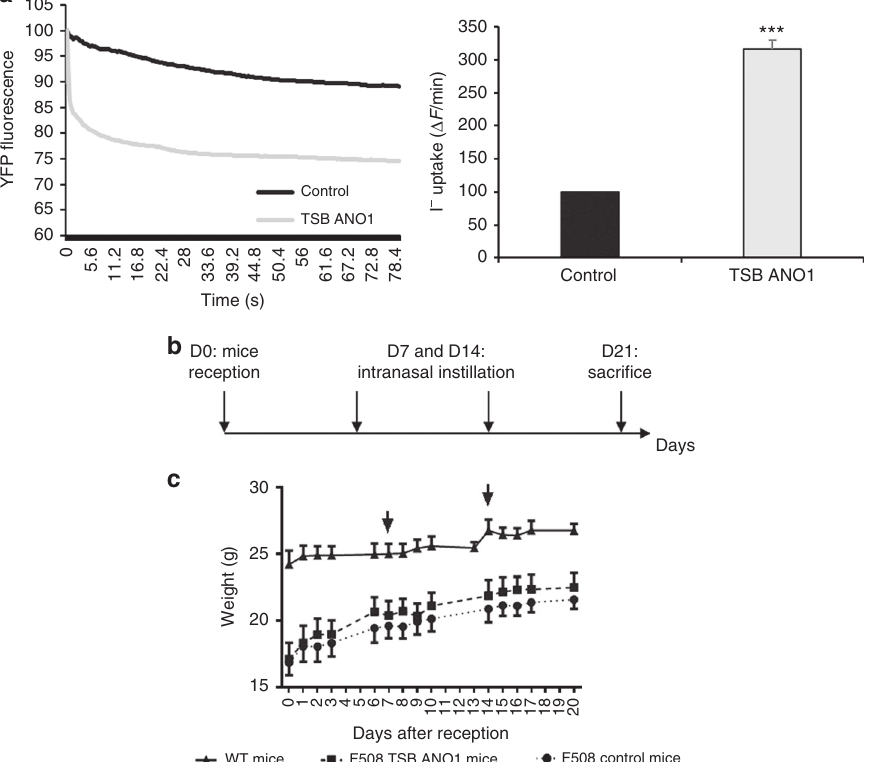
Fig. 6 miR-9-speci fi c TSB is well tolerated in CF mice. For all the experiments, we used 8-week-old male 129-C ftr t m1Eur CF model mice homozygous for the F508del mutation in the 129/FVB outbred background (F508del-CFTR) and their wild-type littermates obtained from CDTA-CNRS (Orléans, France). a Representative and original traces of ANO1 channel activity ( left ) and quanti fi cation ( right ) of MLE15 cells transfected with TSB control (control) or ANO1 TSB. Histograms represent average values ± SDs ( n = 5) and were compared using Student ’ s t -test. b Outline of the CF mouse experiment. TSB control or ANO1 TSB was instilled intranasally at days 7 and 14 after reception (day 0), and mice were killed at day 21. c Growth curves of mice from the day of reception (day 0). Arrows represent intranasal